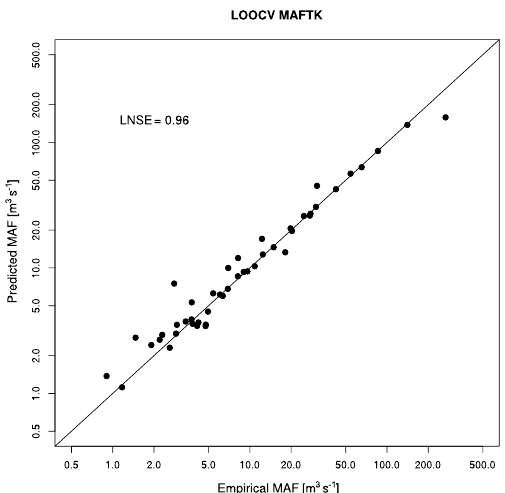
Figure 5. Top-kriging predictions of mean annual flow (MAF) in cross-validation